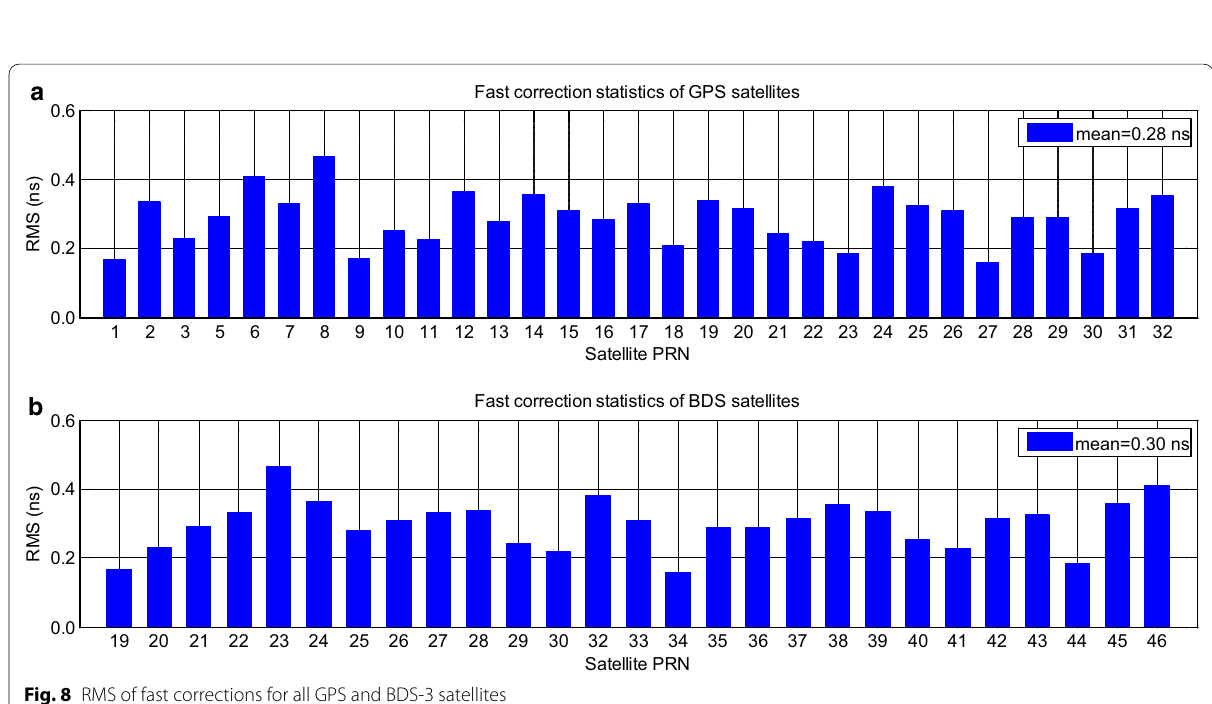
Fig. 8 RMS of fast corrections for all GPS and BDS-3